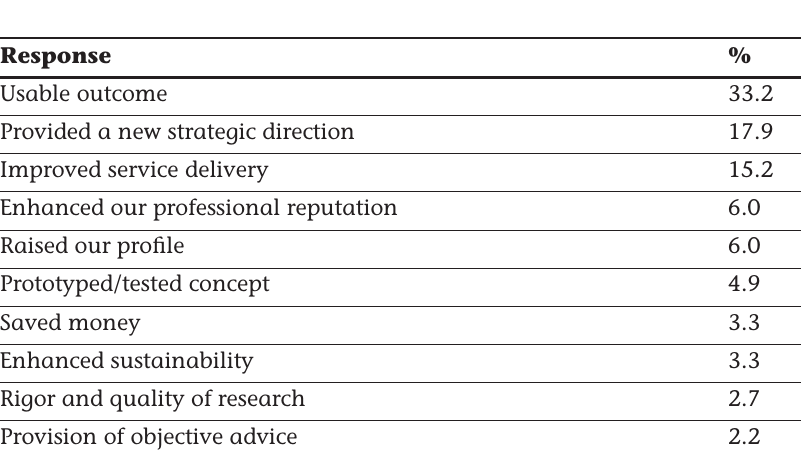
Table 5: Summary of the value